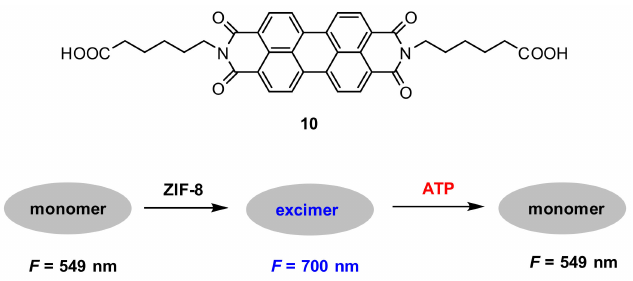
Figure 29. Schematic representation for the detection of ATP with probe 10@ZIF-8 .